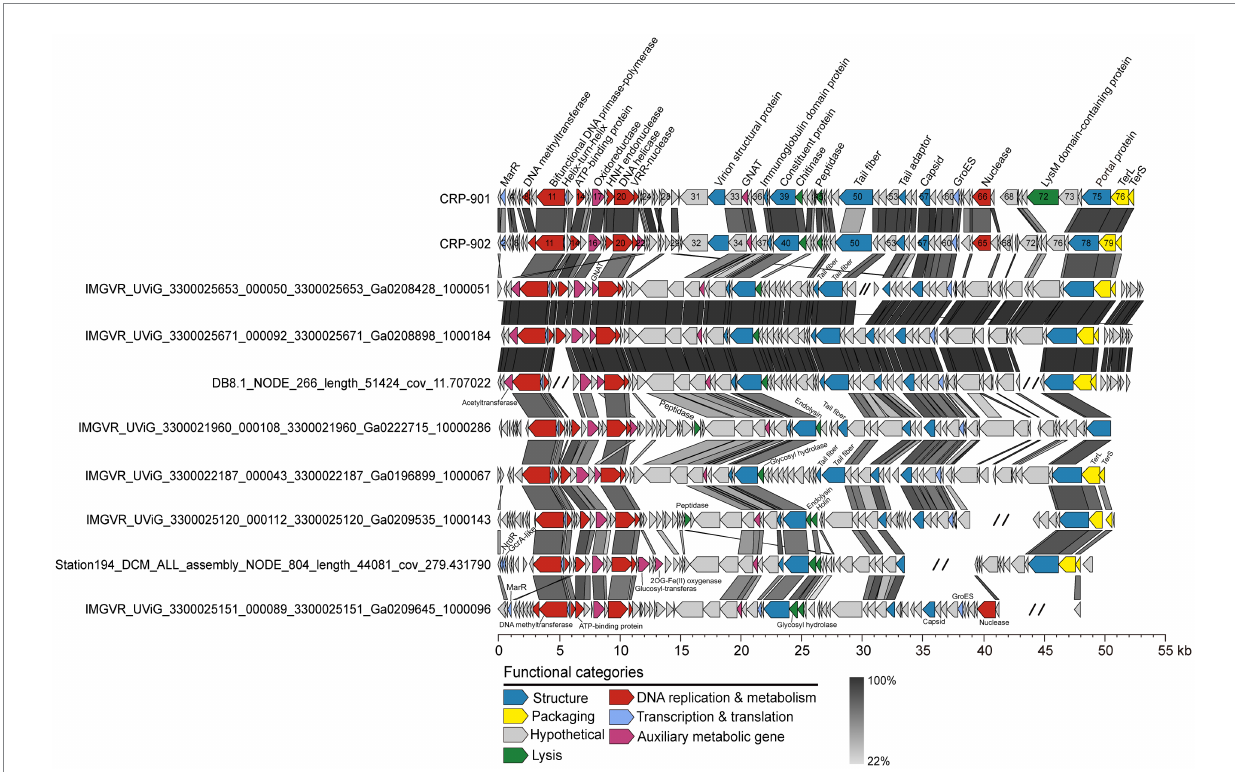
FIGURE 2 Genome alignment and comparison for CRP-901, CRP-902, and representative CRP-901-type MVGs. ORFs are color-coded according to their putative functions. The scale color bar indicates amino acid identities between homologous genes. MarR, MarR family transcriptional regulator; TerS, terminase, small subunit; TerL, terminase, large subunit; GNAT, GCN5-Related N-acetyltransferases; GroES, Co-chaperonin